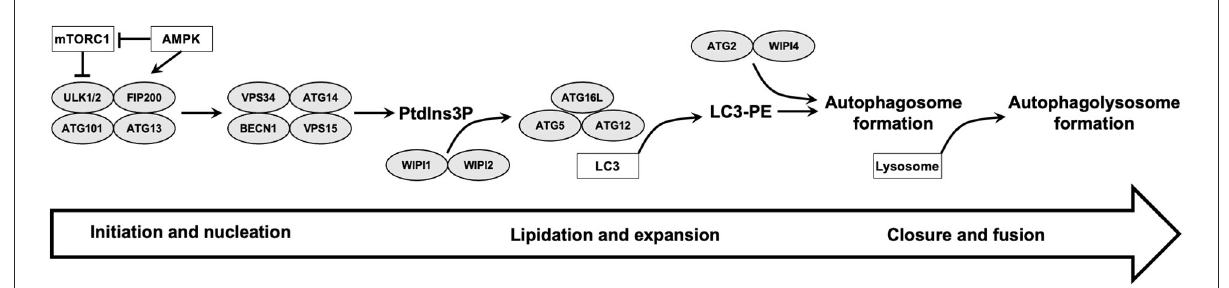
FIGURE1 Summary of different steps of autophagy and role of WIPI proteins is illustrated. ULK1/2 and VPS34 complexes are involved in initiation and nucleation steps. The produced phosphatidylinositol 3-phosphate (PtdIns3P) pool recruit downstream autophagy proteins, including WIPI2 which recruits ATG16L complex for LC3 lipidation and autophagosome formation. WIPI4 binds to ATG2 and the ATG2-WIPI4 complex acts as a tethering factor for phagophore expansion. Finally, the expanding autophagosome closes and fuses with